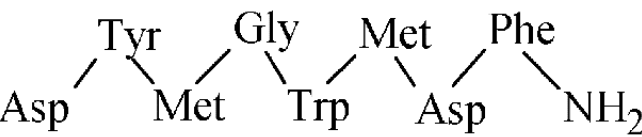
Figure 14. The AA sequence of octapeptide cholecystokinin. Table 9. Summary of radiolabeled CCK/minigastrin analogues for CCKR-positive tumor imaging over past 3 years. Composition of Studied Compounds